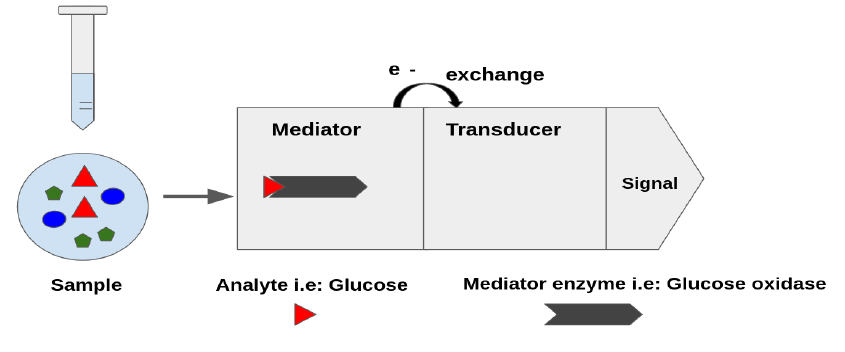
Figure 1. Scheme of an example of an amperometric glucose biosensor.